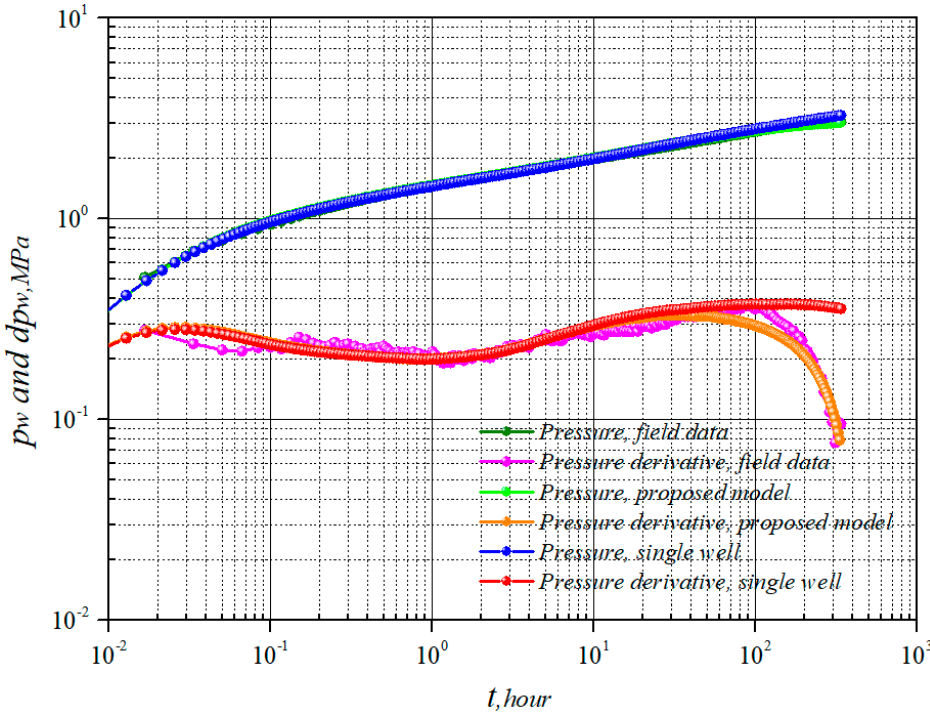
Figure 11. Pressure and pressure derivative match results in the fourth cycle of cumulative gas injection for case 1. Table 5. The reservoir, well, and gas properties in pressure transient analysis of case 1.